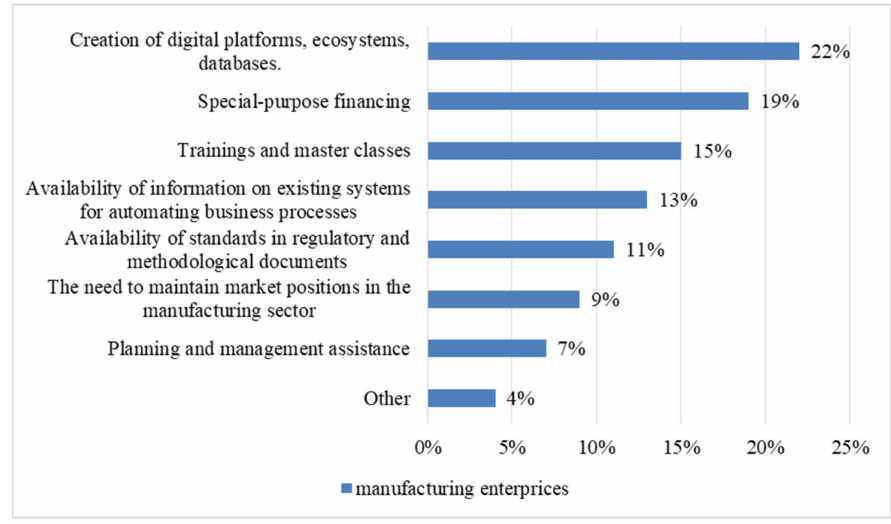
Figure 11. Stimulus for digital transformation of operations manufacturing enterprises of the Repub- lic of Mordovia.